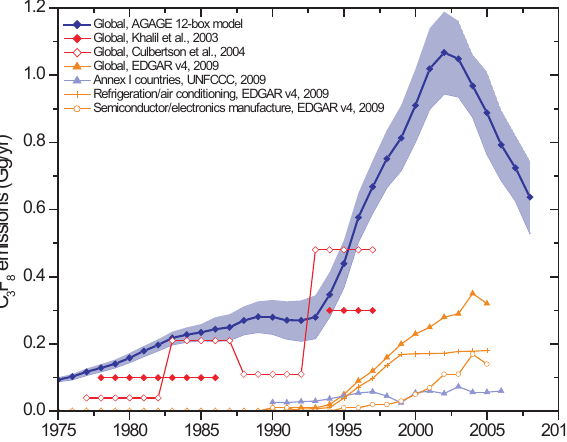
Fig. 6. Global C 3 F 8 emissions from the inversion of AGAGE at- mospheric data with the AGAGE 2-D 12-box model compared to emissions reported by Khalil et al. (2003), Culbertson et al. (2004), the EDGAR v4 (2009) emission database, and Annex I countries (UNFCCC, 2009, Table S1). Also shown are EDGAR v4 emis- sion estimates for refrigeration/air conditioning and semiconduc- tor/electronics